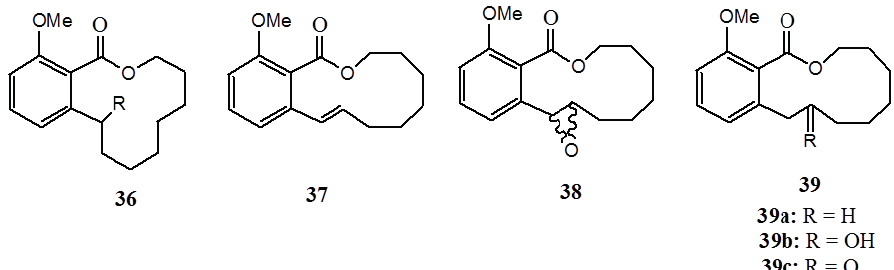
Figure 14. The macrolides ( 36 – 39